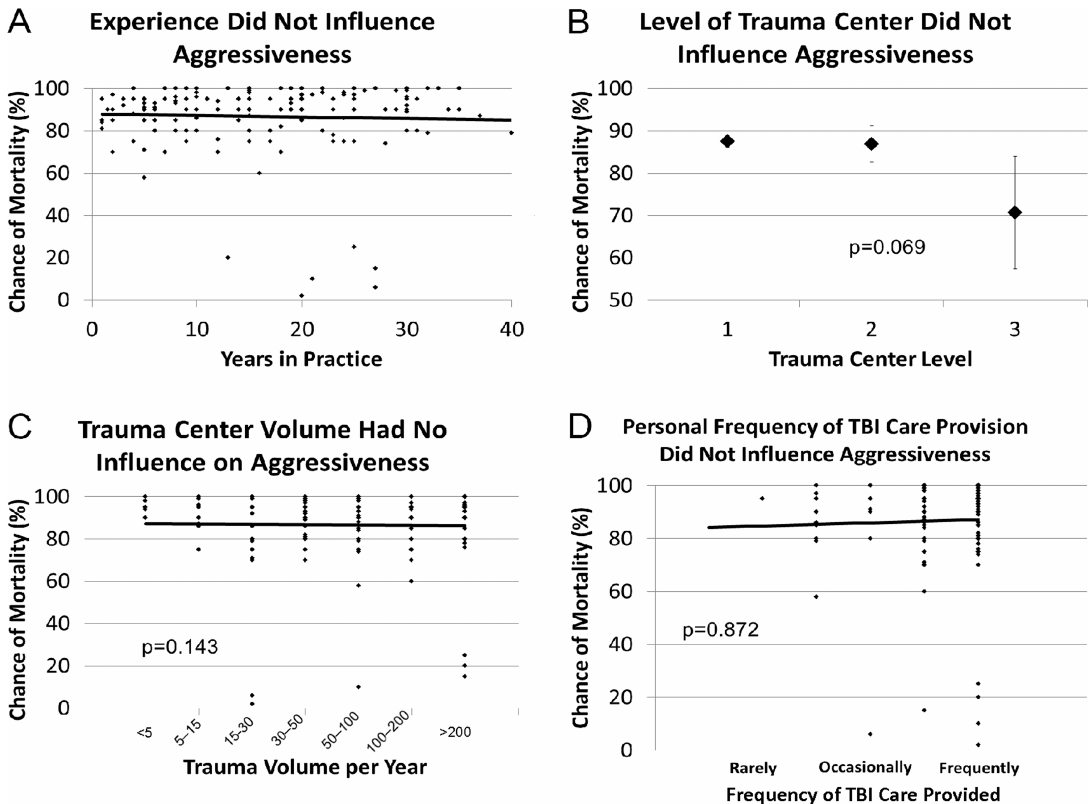
Fig 4. Effect of variables on physician aggressiveness. A) Chanceof mortality that prompts withholding aggressivecare by years in practice. B) Chance of mortality that prompts withholding aggressivecare by trauma center level. C) Chanceof mortality that prompts withholding aggressivecare by trauma volume per year. D) Chanceof mortality that prompts withholding aggressivecare by frequencyof TBI care